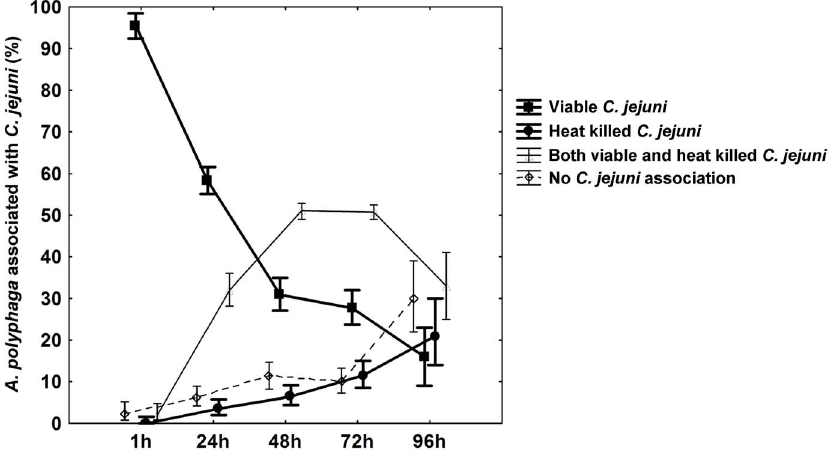
Figure 2. A.polyphaga trophozoites associated with C.jejuni . The fraction of A. polyphaga trophozoites associated with C. jejuni are shown as % of all counted trophozoites at 1 h, 24 h, 48 h and 72 h after infection. The trophozoites registered at each time point fall into one of the following categories: Trophozoites associated with viable C. jejuni only (squares), associated with heat killed C. jejuni only (circles), associated with both viable and heat killed C. jejuni (triangles) or associated with no C. jejuni (diamonds). Among the trophozoites associated with both viable and heat killed C. jejuni, the amount of viable C. jejuni were dominating at all time points except at 96 h. Data are based on three to five independent experiments for samples taken at 1 h–72 h and on one experiment for 96 h. Mean 6 95 confidence interval.